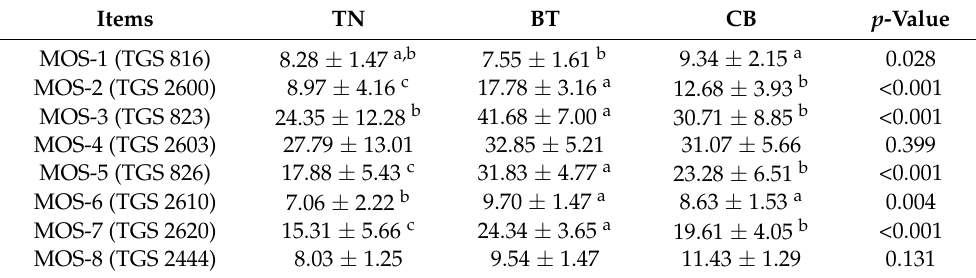
Table 2. Sensing response (%) of beef loins (M. Longissimus dorsi) from different breeds. Items TN BT CB p -Value MOS-1 (TGS 816) 8.28 ± 1.47